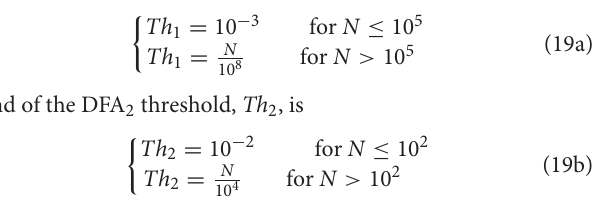
Frontiers in Physiology |